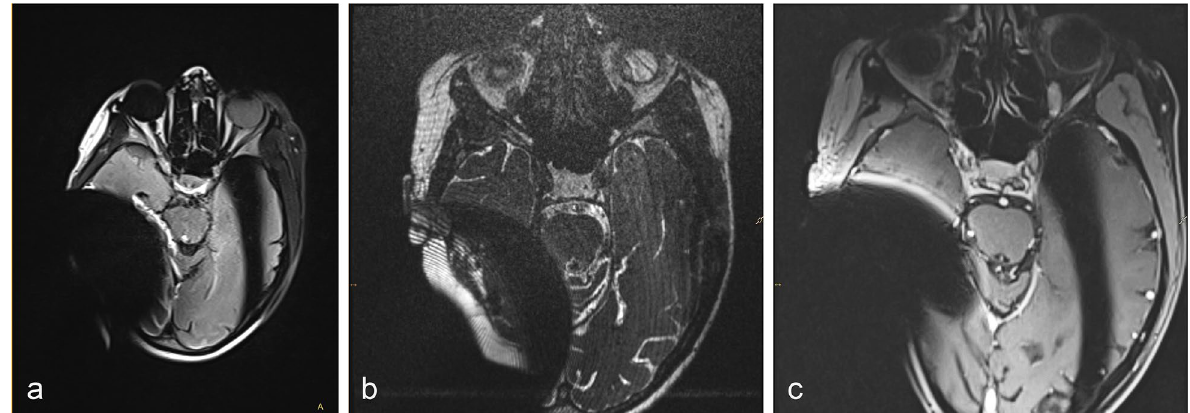
Fig. 4 Examples of transverse gradient-echo (GRE) MR images illustrating extent of CI artifact in a 53-year-old female patient to depict cochlear anatomy and vestibulocochlear nerve on the contralateral side a : T2-weighted FLAIR image (FOV 250 3.0 mm, slice gap 0.6 mm), b T2/T1-weighted 3D CISS image, coherent balanced GRE using dual-excitation (FOV 180 contrast-enhanced T1-weighted fat-saturated VIBE image, spoiled 3D GRE with volume interpolation (FOV 160